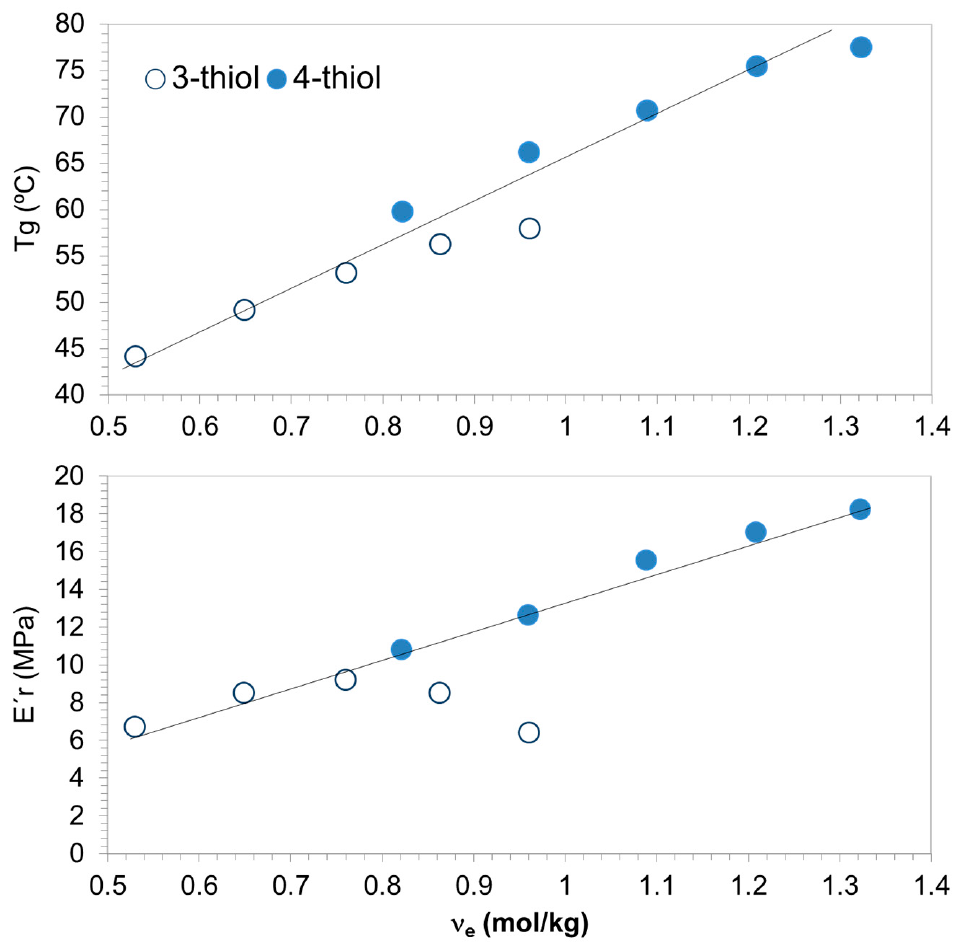
Figure 7. ( T g ) and ( E r ′ ) with respect to the effective strand density ( v e ) corresponding to each % of iso content.